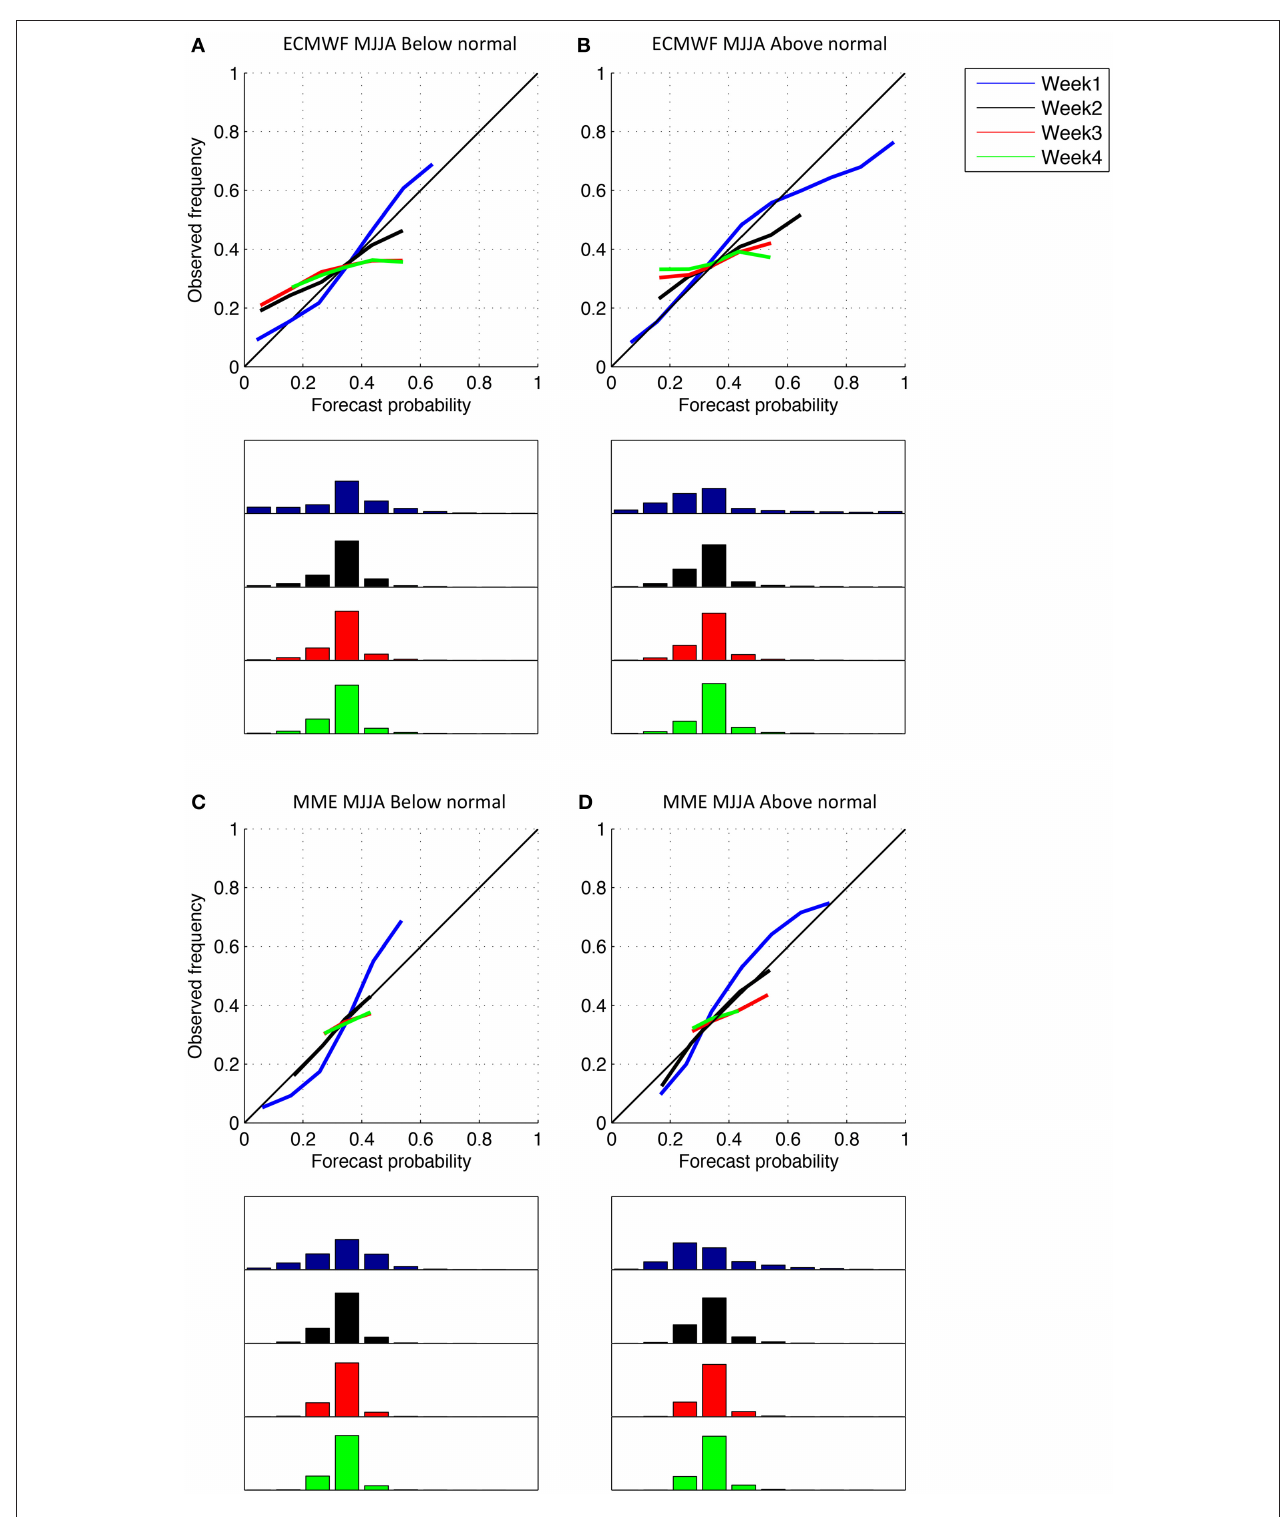
FIGURE 2 | Reliability diagrams for the below- and above- normal categories from ECMWF forecasts (A,B) and the MME of ECMWF, NCEP, and CMA forecasts (C,D) for starts in May-Aug computed for landpoints of the North American summer monsoon region shown in Figure 5 , with color coding based on week leads. The frequencies with which each category is forecasted are indicated as bins centered on integer multiple of 0.10 in histograms plotted under the respective tercile category diagram. The bins are projected along the same x-axis (forecast probabilities from 0 to 1) and scaled from 0 to 100%. Note that only bins with more than 1% of the total number of forecasts in each category are plotted in the relative diagrams for each lead.